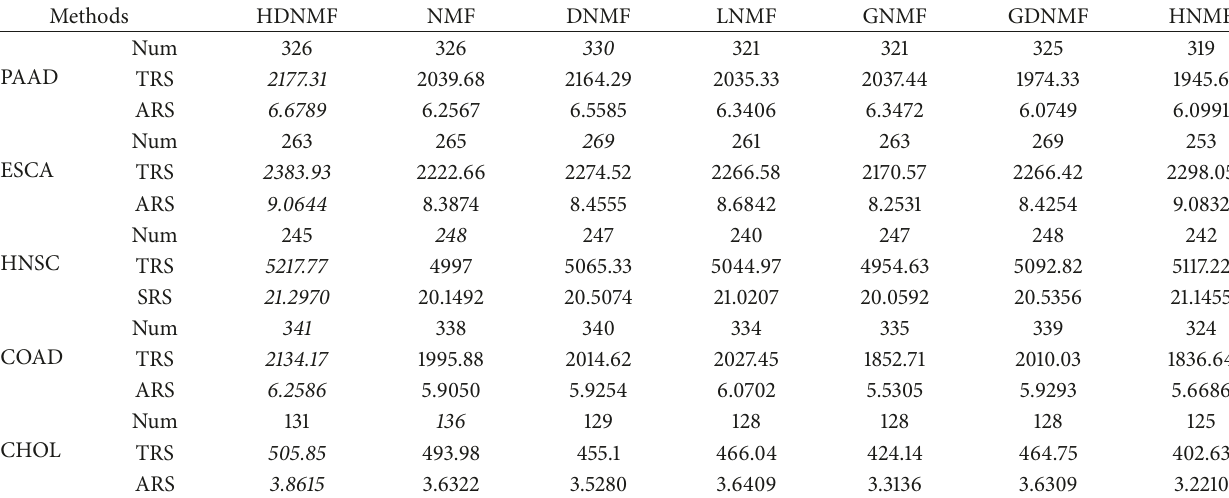
Table 8: NUM, TRS, and ARS of five methods (INTA 2).